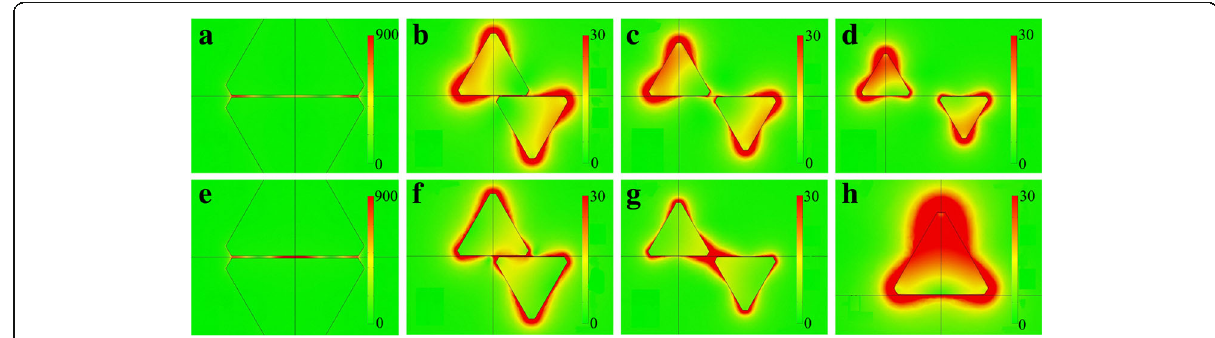
Fig. 3 Calculated electric field distributions of Ag TNP dimers and monomer. Images are taken as the cross-section of the Ag TNP dimer at z =0 on the x-y plane. Panels a – g correspond to the points A – G marked in Fig. 2a. Peak 1: a R =0; b R =0.5, B; c R =1; d R =1.5. Peak 2: e R =0, f R =0.5, g R =1. h